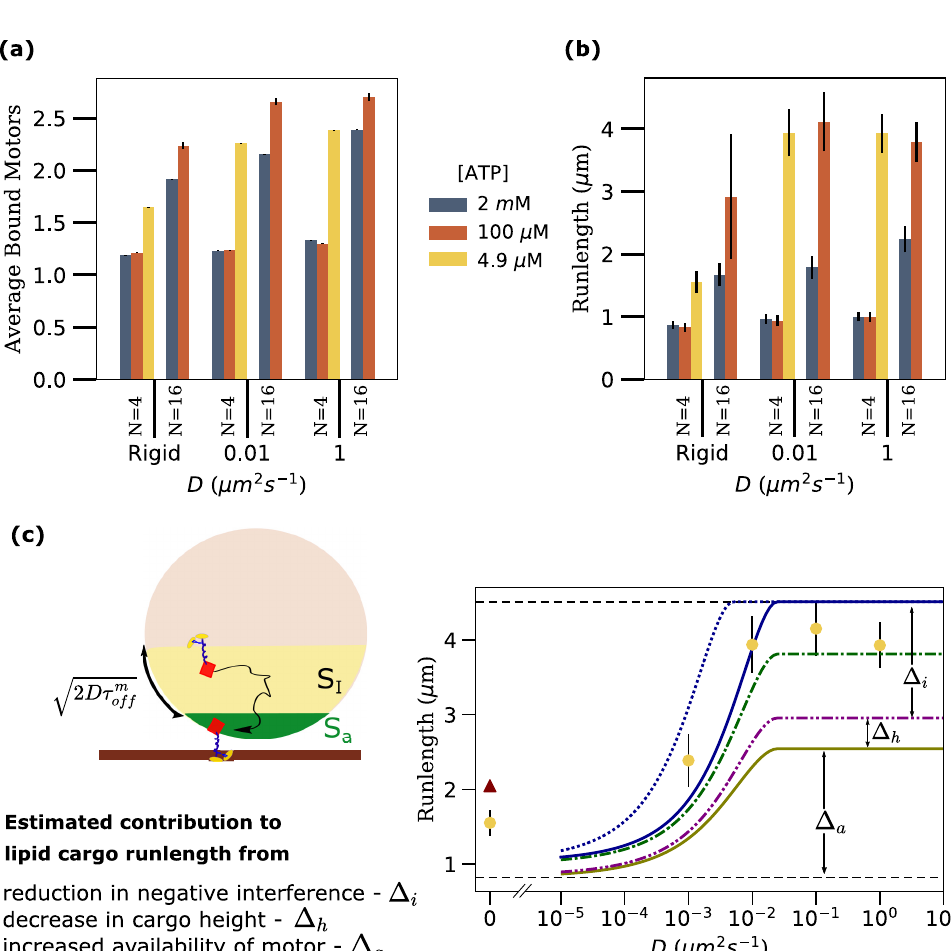
Fig 5. Fluid cargo have longer run lengths than rigid cargo. (a) Average number bound motors, (b) Runlength as a function of diffusivity ( D ) for two different numbers of motors on the cargo ( N ) and three different ATP concentrations. 200 cargo runs were considered for each parameter set. Error bars represent the standard error of the mean (SEM). The average number of bound motors in (a) was calculated as the mean of the number of bound motors ( n ) in all time samples (with data sampling rate = 100 s − 1 ) of these 200 cargo runs. Rotational diffusion of cargo was not considered in these simulations. The sample size was large and hence the error bars obtained as the standard error of the mean is very small. (c) Comparison between run lengths from our simulations ( N = 4, [ATP] = 4.9 μM , yellow circles) and analytical estimates (maroon triangle, solid, dashed and dash-dotted lines) as described in the text. Left cartoon : A lipid cargo, with ffiffiffiffiffiffiffiffiffiffiffiffi p access area ( S , green) and influx area ( S , yellow) shown. Influx area is defined as the region within 2 D t m from the a I off access area.